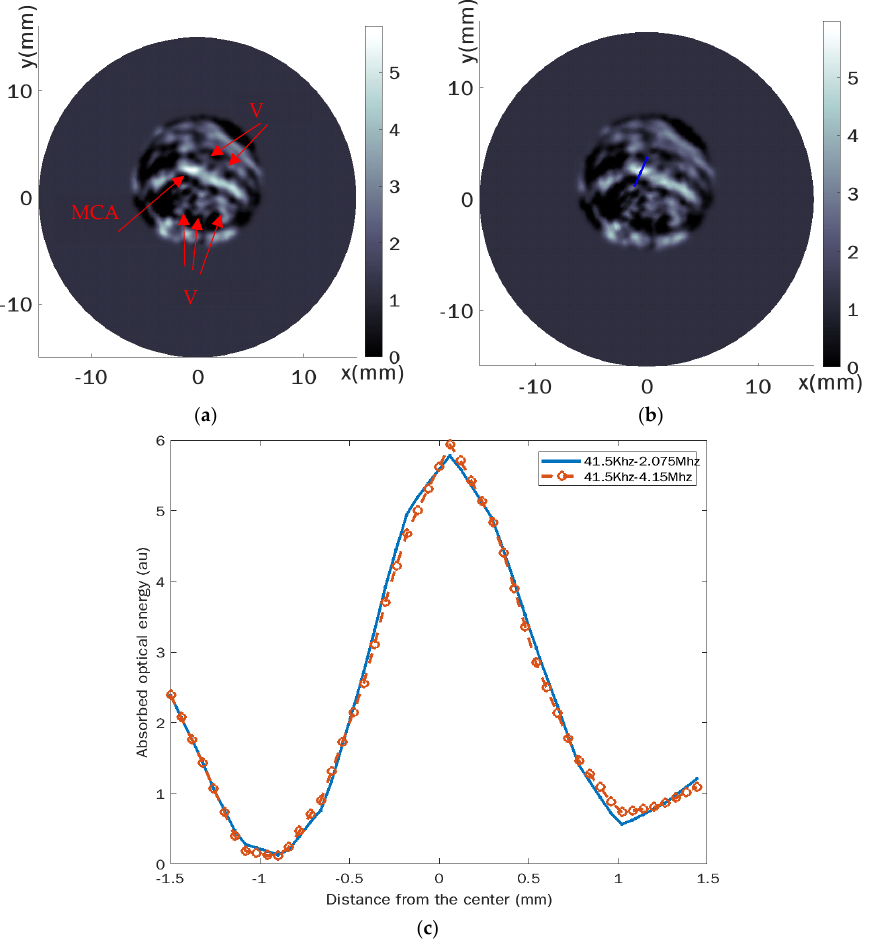
Figure 6. Reconstructed photoacoustic images of the in vivo rat’s brain ( a , b ) and the qualitative profile across MCA ( c ) using the localized FE-PAT algorithm in a ROI with a radius of 6 mm. The frequency range used in the reconstruction was 41.5 Khz–2.075 Mhz ( a ) and 41.5 Khz–4.15 Mhz ( b ). MCA: middle cerebral artery; V: blood vessels. The transection line was marked as the blue line in ( c ).